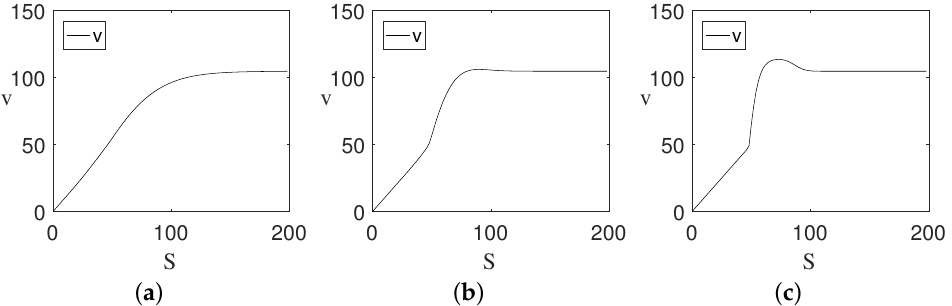
Figure 2. ( a ) denotes v for different S when H = 0.3, ( b ) denotes v for different S when H = 0.5 and ( c ) denotes v for different S when H =